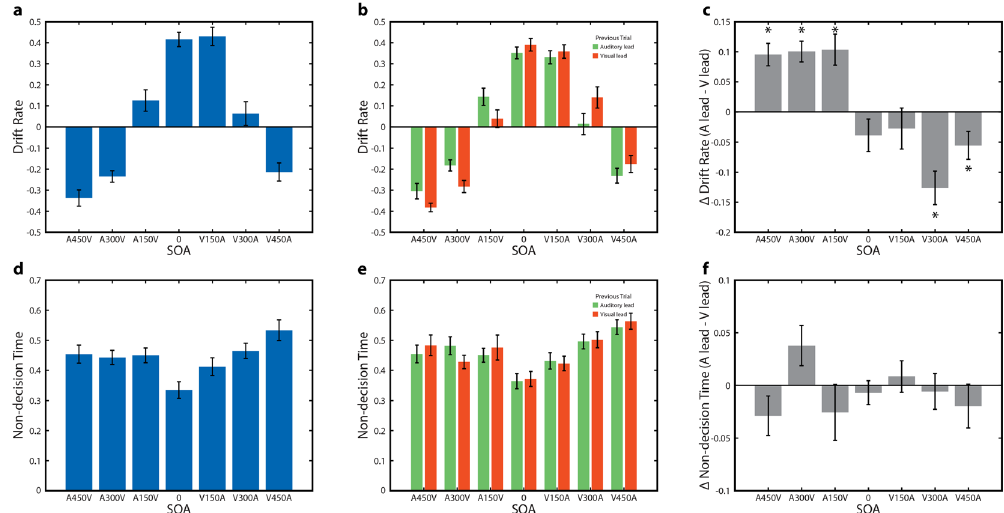
Figure 3. Drift Diffusion Model Results. ( a ) Drift rate for each of the seven SOAs for a model pooled across auditory leading and visual leading trials. Error bars indicate standard error of the mean. ( b ) Drift rate for each of the seven SOAs for two models fit separately based on whether the previous trial was auditory leading or visual leading. Error bars indicate standard error of the mean. ( c ) Difference in drift rate (auditory lead – visual lead) between the two models in panel B. Error bars indicate standard error of the mean. ( d ) Non-decision time for each of the seven SOAs for a model pooled across auditory lead and visual lead trials. Error bars